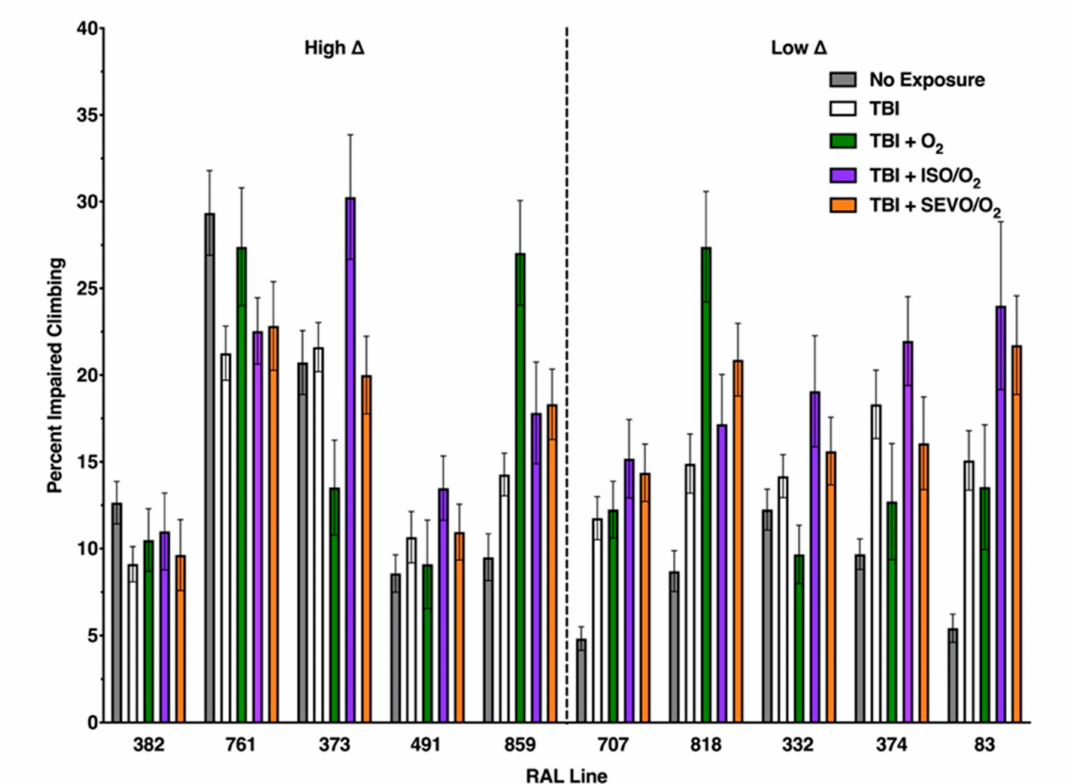
Figure 5. Genetic background alters the e ff ect of exposure to O 2 , ISO / O 2 , or SEVO / O 2 on percent impaired climbing 24 h after TBI. Percent impaired climbing was determined for the ten RAL lines that were analyzed in Figures 1–4 and displayed in the same order as Figure 1 in high ∆ and low ∆ groups. Percent impaired climbing was determined for uninjured and unexposed flies (No Exposure) as well as injured flies and the same exposure conditions as Figure 1. Higher bars indicate more